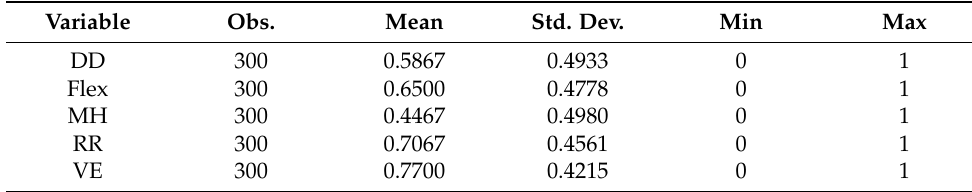
Table 2. Summary statistics.